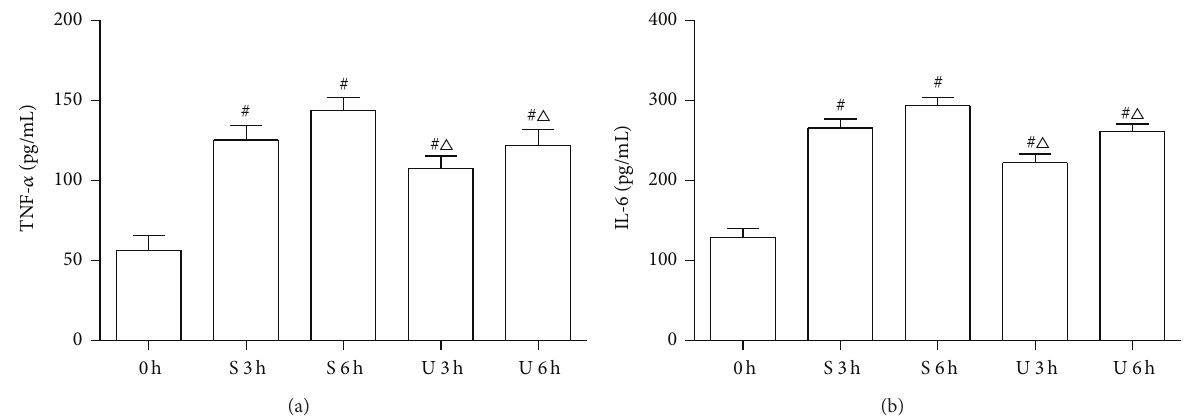
Figure 1: Effects of UTI on TNF- 𝛼 (a) and IL-6 (b). 0 h = C group; S 3 h = S group at 3 h; S 6h = S group at 6 h; U 3h = U group at 3 h; U 6h = U group at 6 h. # 𝑃 < 0.05 versus C group and △ 𝑃 < 0.05 versus S group at matched